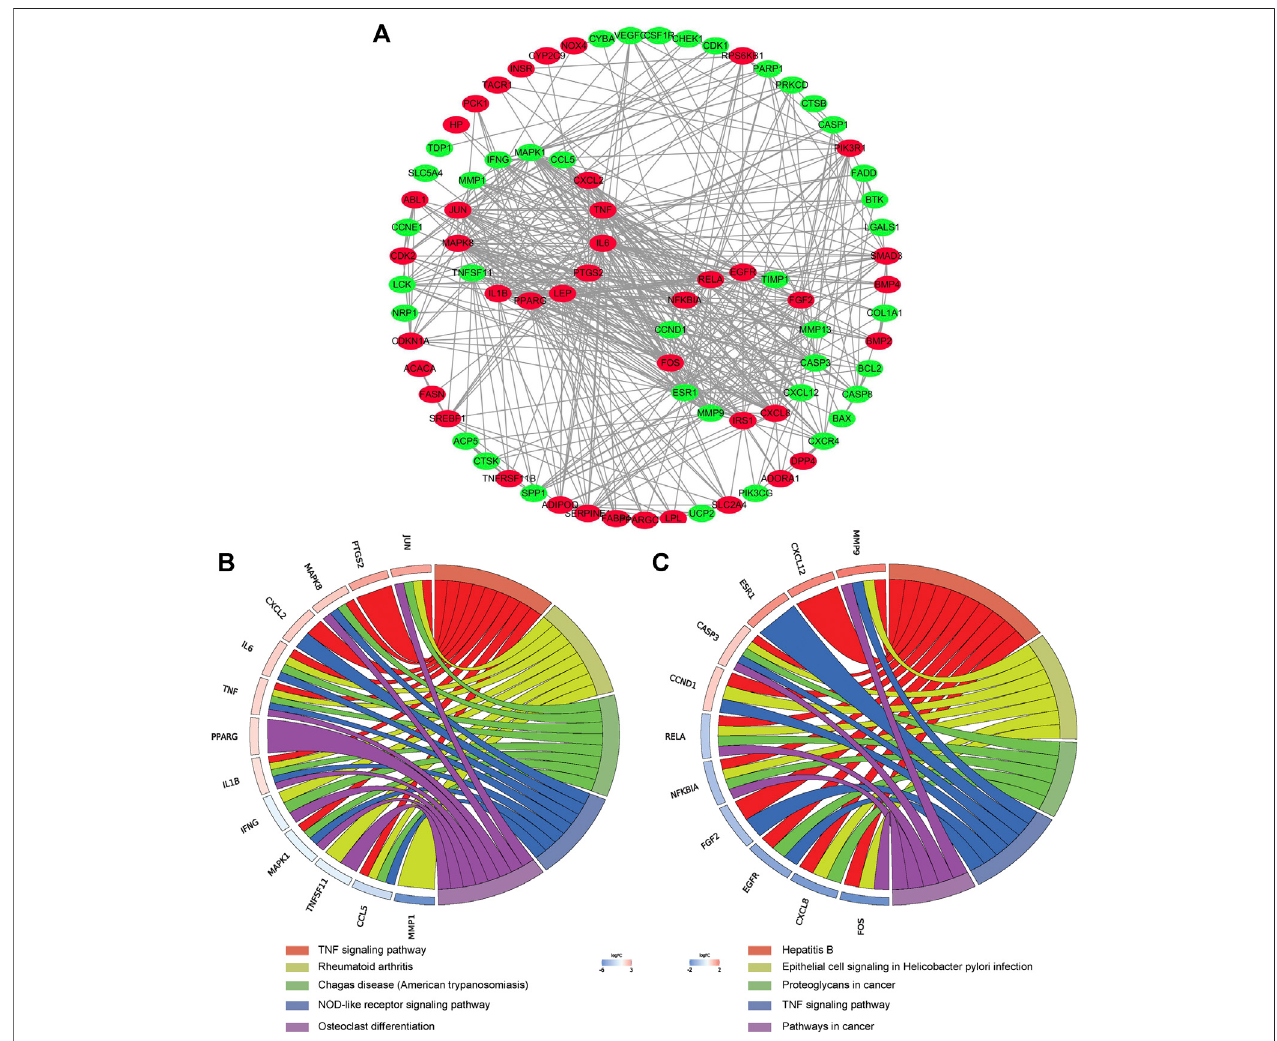
FIGURE 5 | PPI network construction. (A) PPI network construction of key targets (subnetworks from MCODE analysis were arranged in circles). (B) (C) KEGG pathway analysis of genes in the subnetwork (top fi ve were listed).